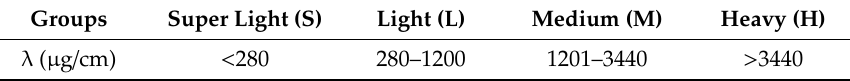
Table 2. Di ff erent major fabric groups based on possible λ values